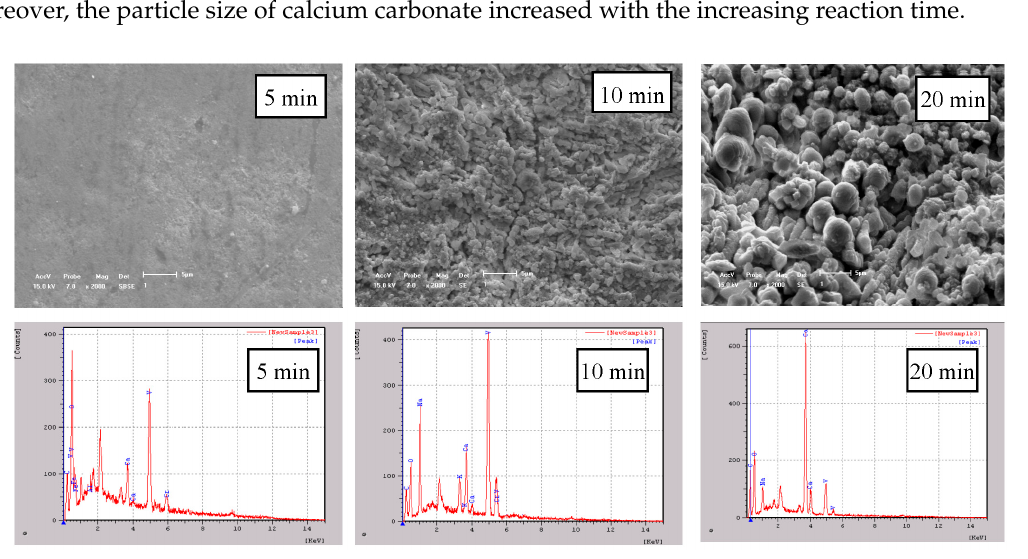
Figure 4. SEM images and EDS analysis of the surface of calcium metavanadate at different leaching time (20 °C, sodium carbonate).